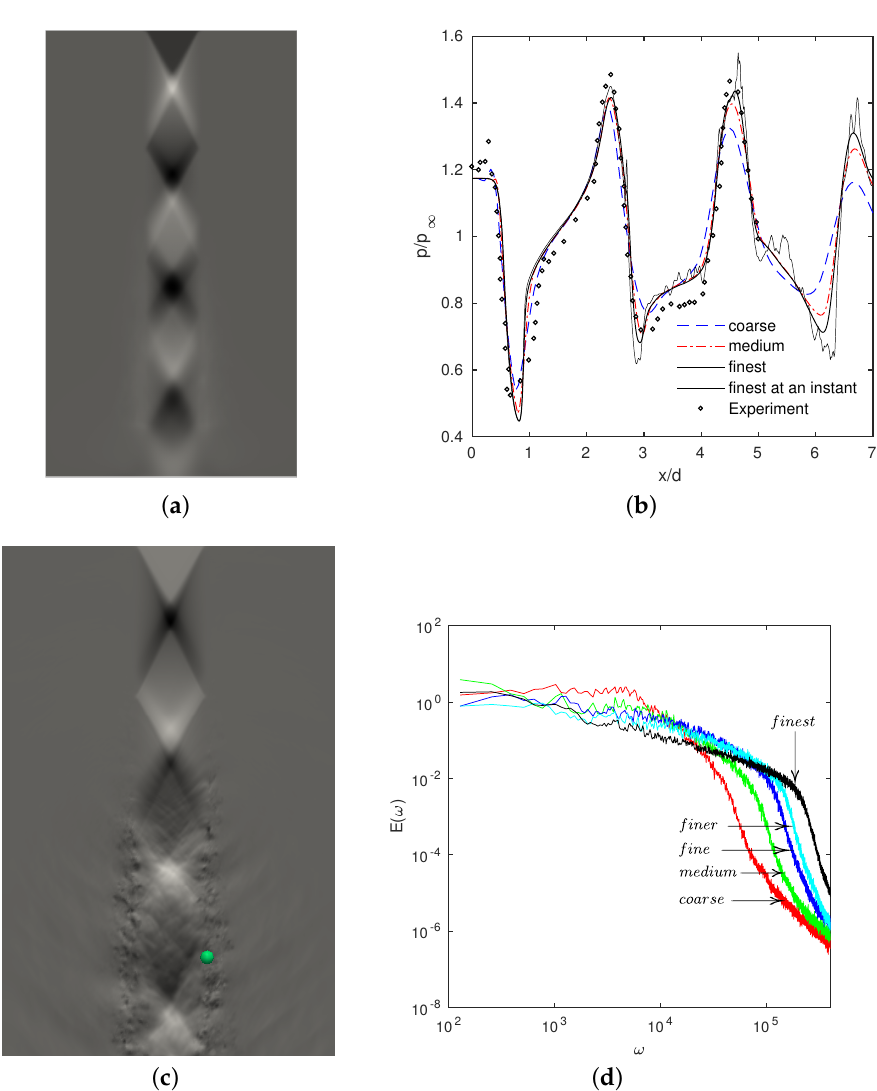
Figure 10. LES of underexpanded jet for M j = 2.103, p 0 / p a = 9.187. Experiment by Norum and Seiner [32] (case on page 27 of their report). ( a ) Mean pressure on longitudinal plane. ( b ) Pressure along jet axis. Curves for simulation data, symbol for experiment. ( c ) Instantaneous pressure on longitudinal plane (Medium grid). ( d ) Energy spectra (at green dot in the left